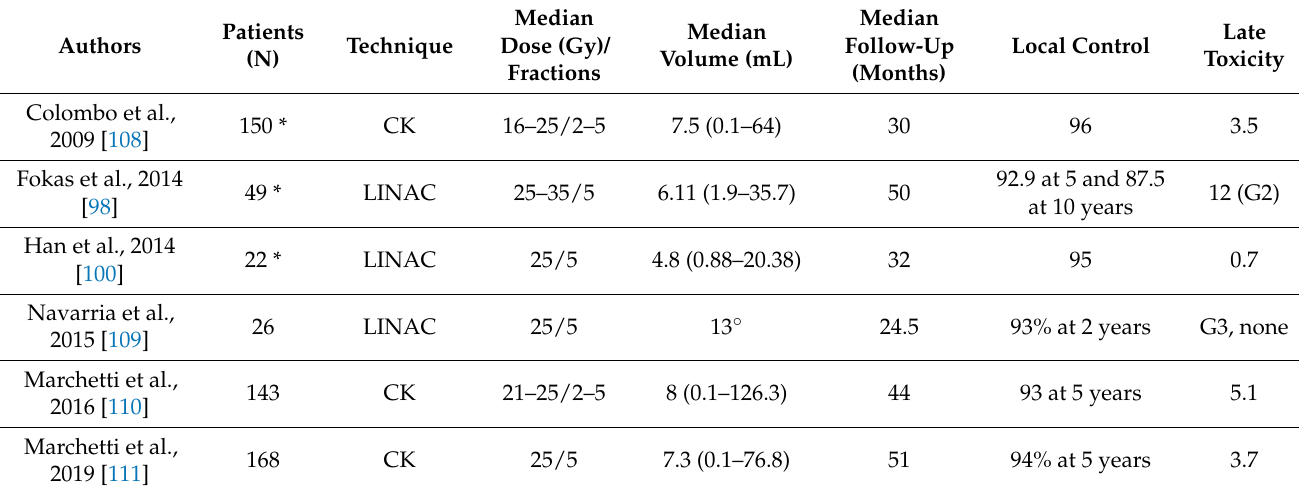
Table 4. Summary of selected published studies on conventionally fractionated radiotherapy for skull base meningiomas.